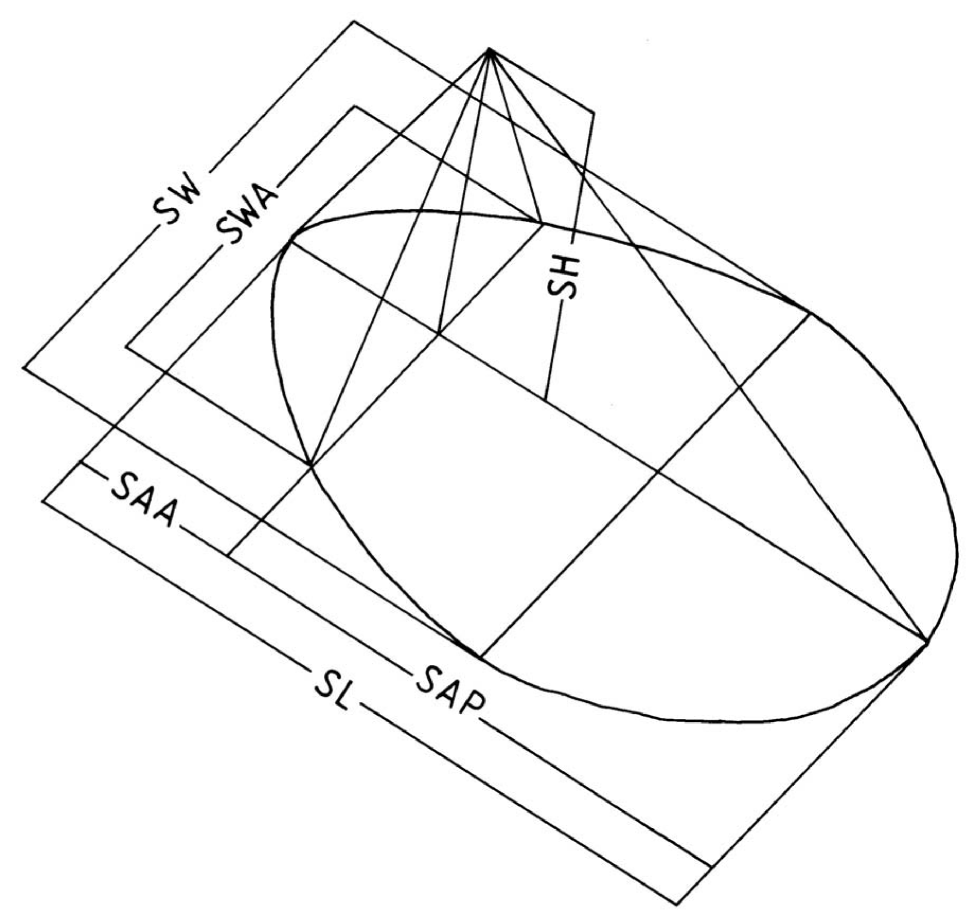
Fig. 2. Distances measured in the shells (description of the variables in the